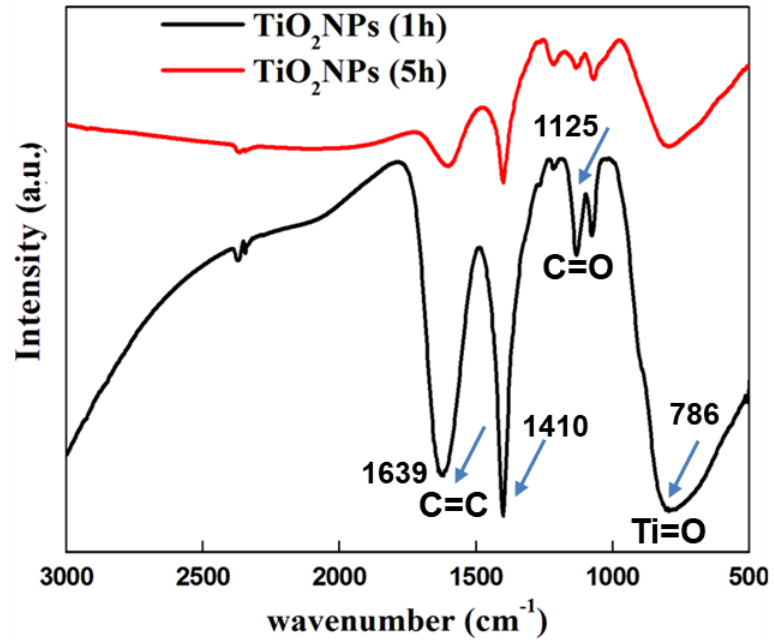
Figure 5. FTIR spectra of TiO 2 nanoparticles.